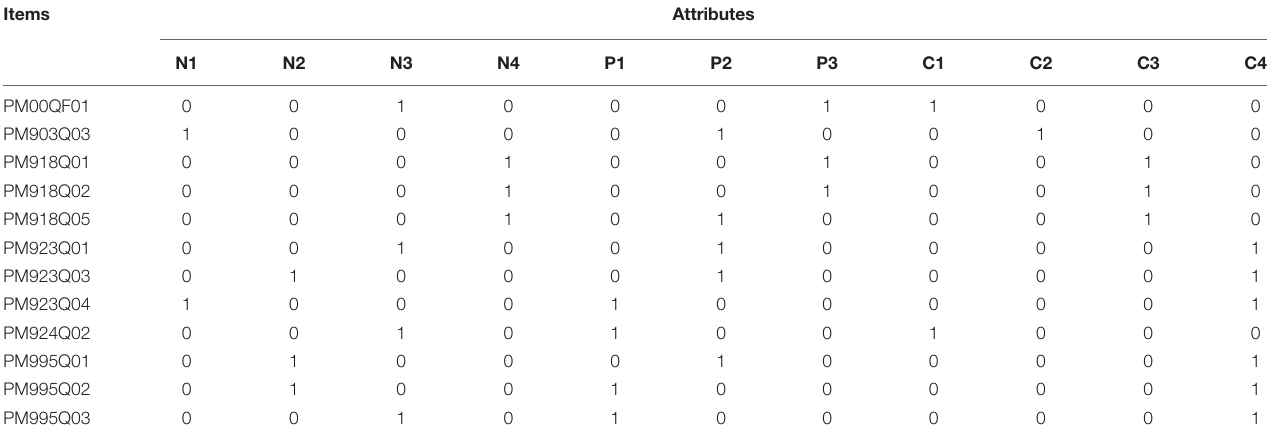
TABLE 2 | Q-matrix of 12 test items in PISA.